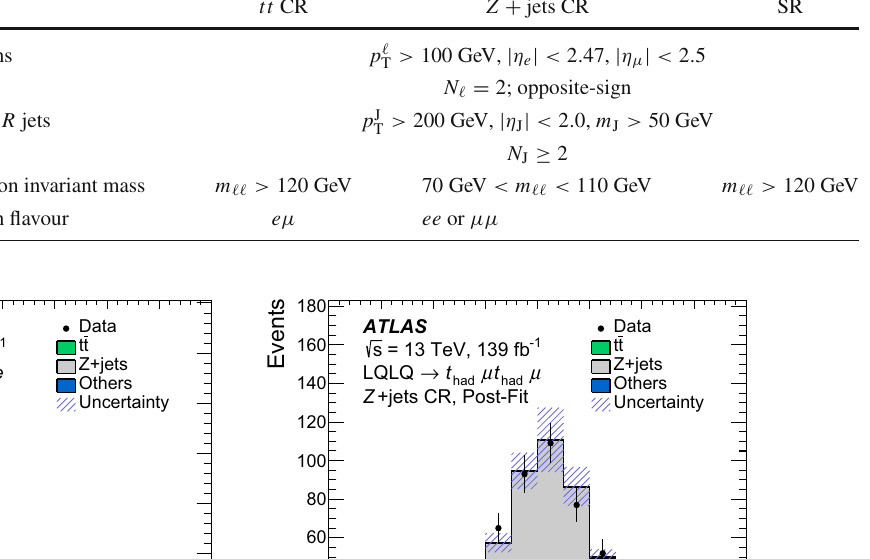
Table 1 Summary of event